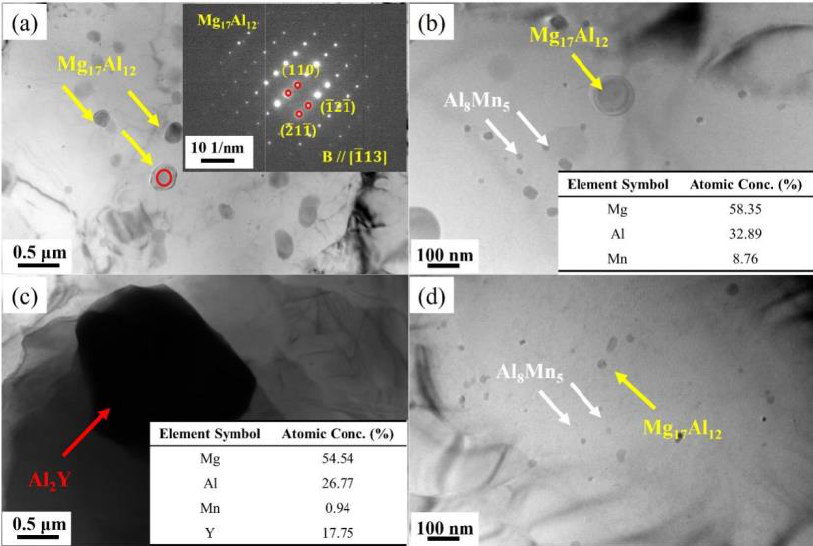
Figure 6. TEM images of the rolled sheets with different Y contents: ( a , b ) AZY0; ( c , d ) AZY3.